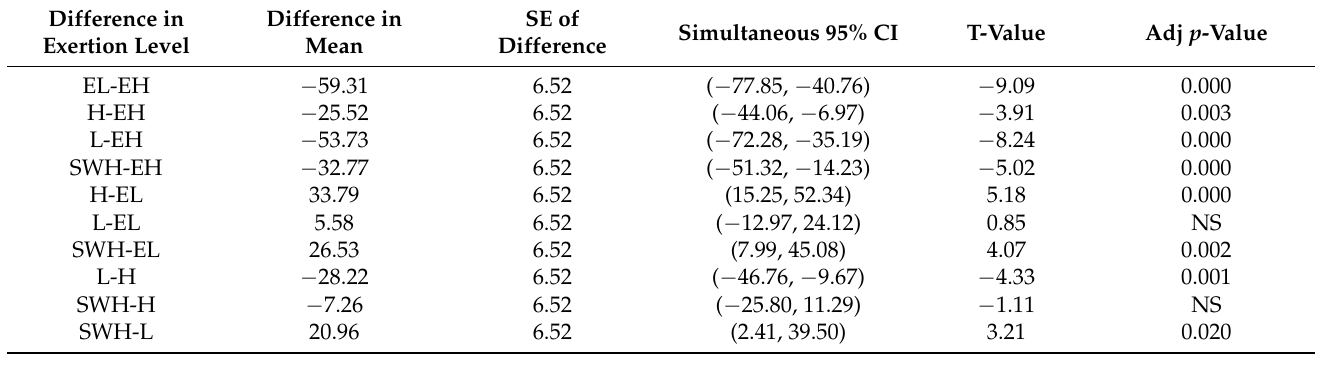
Table 5. Results of Tukey’s post hoc simultaneous tests for differences in means for forces exerted at different physical exertion levels. EL: extremely light, L: light, SWH: somewhat hard, H: hard, EH: extremely hard, CI: confidence interval, NS: not significant, and SE: standard error.